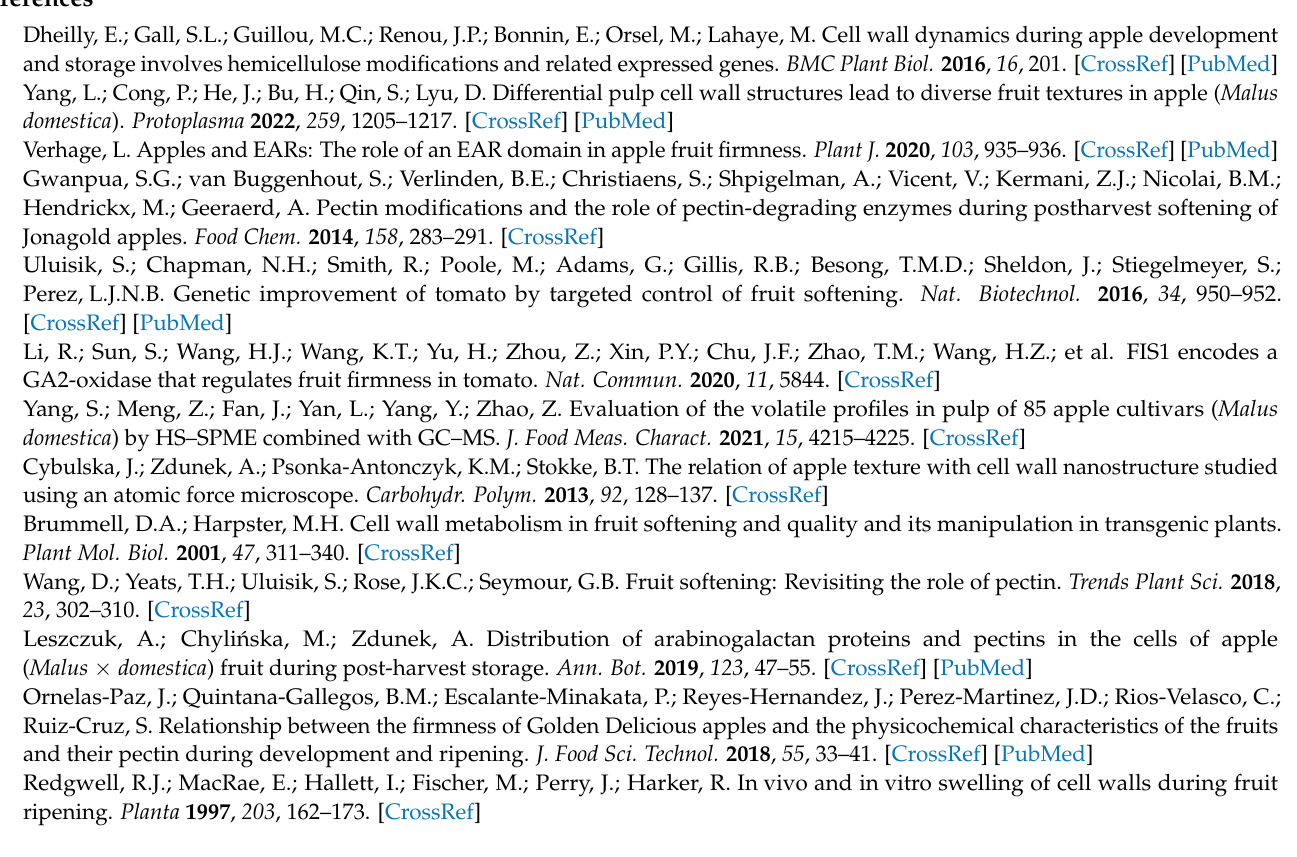
Table S2: The genebank accession numbers used for